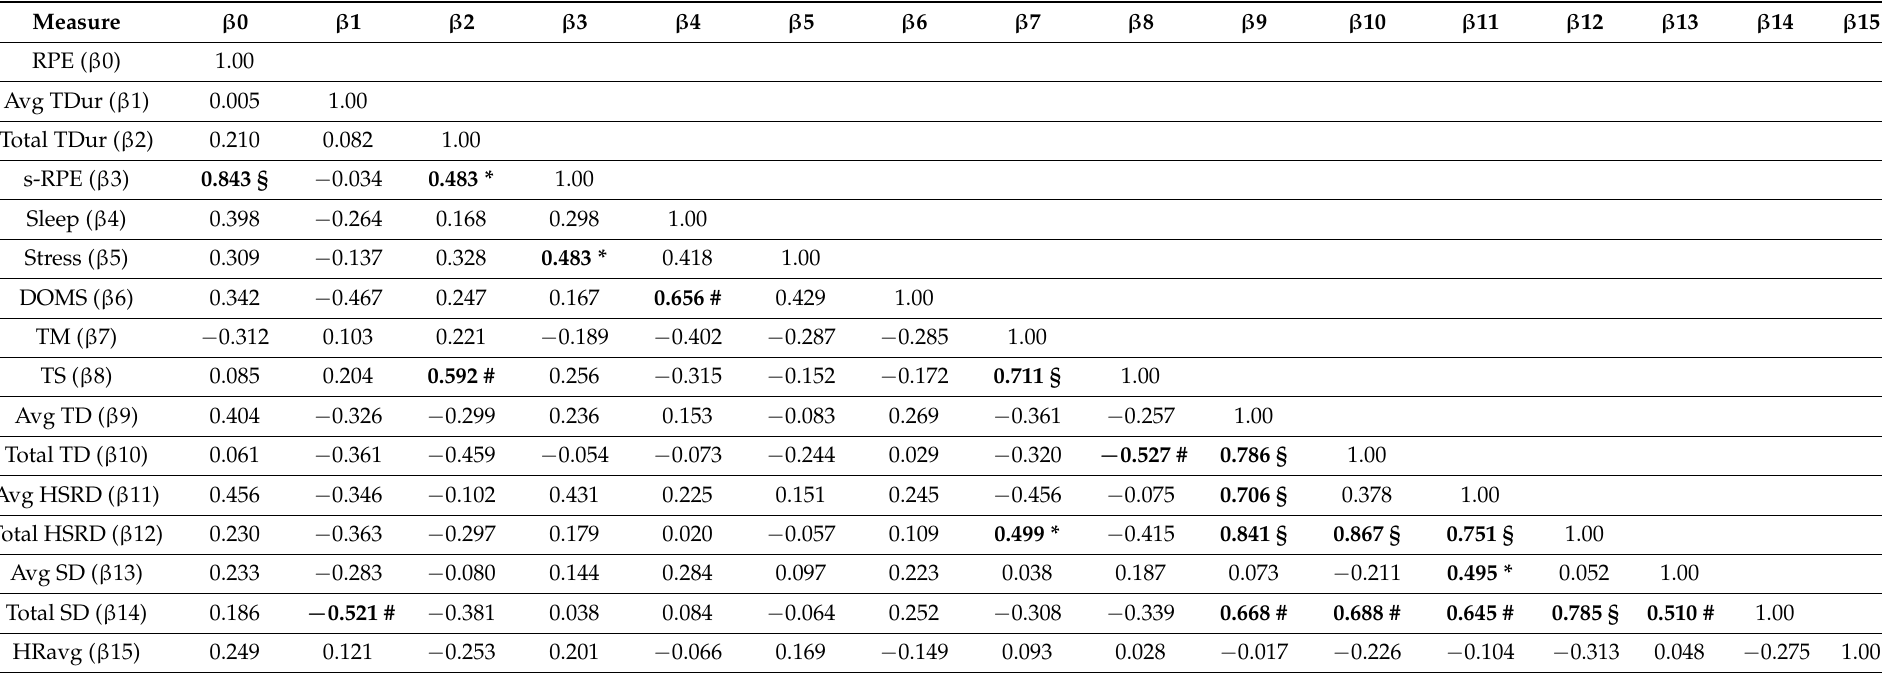
Table 4. Correlation analysis between the measures in study on the